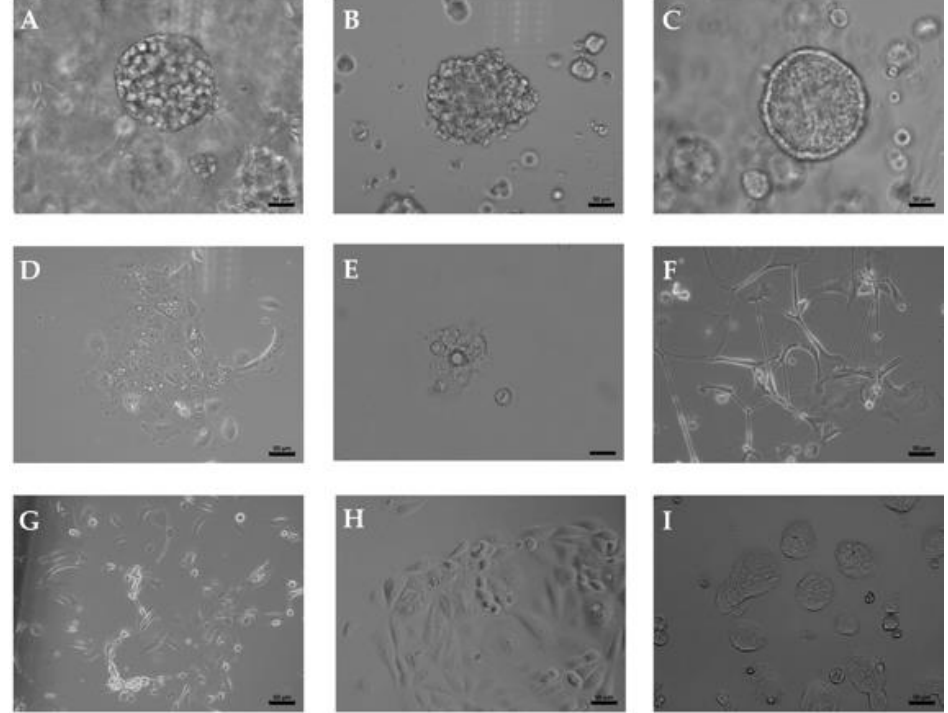
Figure 1. Urothelial carcinoma organoids in culture. Cells from tissue samples derived from BC patient #56 ( A , D ), #140 ( B , E ), and #147 ( C , F ) were expanded as organoids ( A – C ) or adherend 2D standard cultures ( D – F ). Normal urothelial cells ( G ) and BC cell lines HT1197 ( H ) and RT4 ( I ) served as controls. Size bars indicate 50 μm.